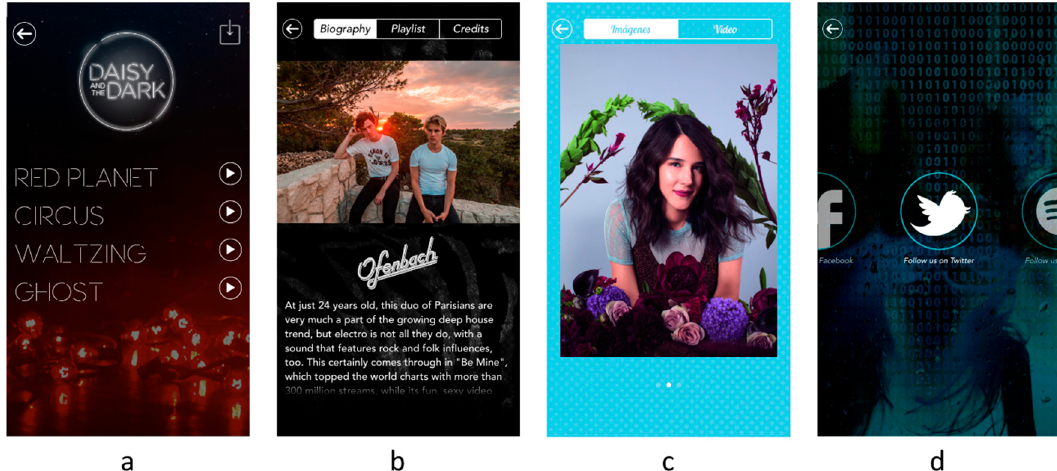
Figure 2. Examples of accessible features from released variPlay apps including: ( a ) Daisy and The Dark music player; ( b ) Ofenbach biography; ( c ) Ximena Sariñana gallery images; and ( d ) Defab1 extras section.